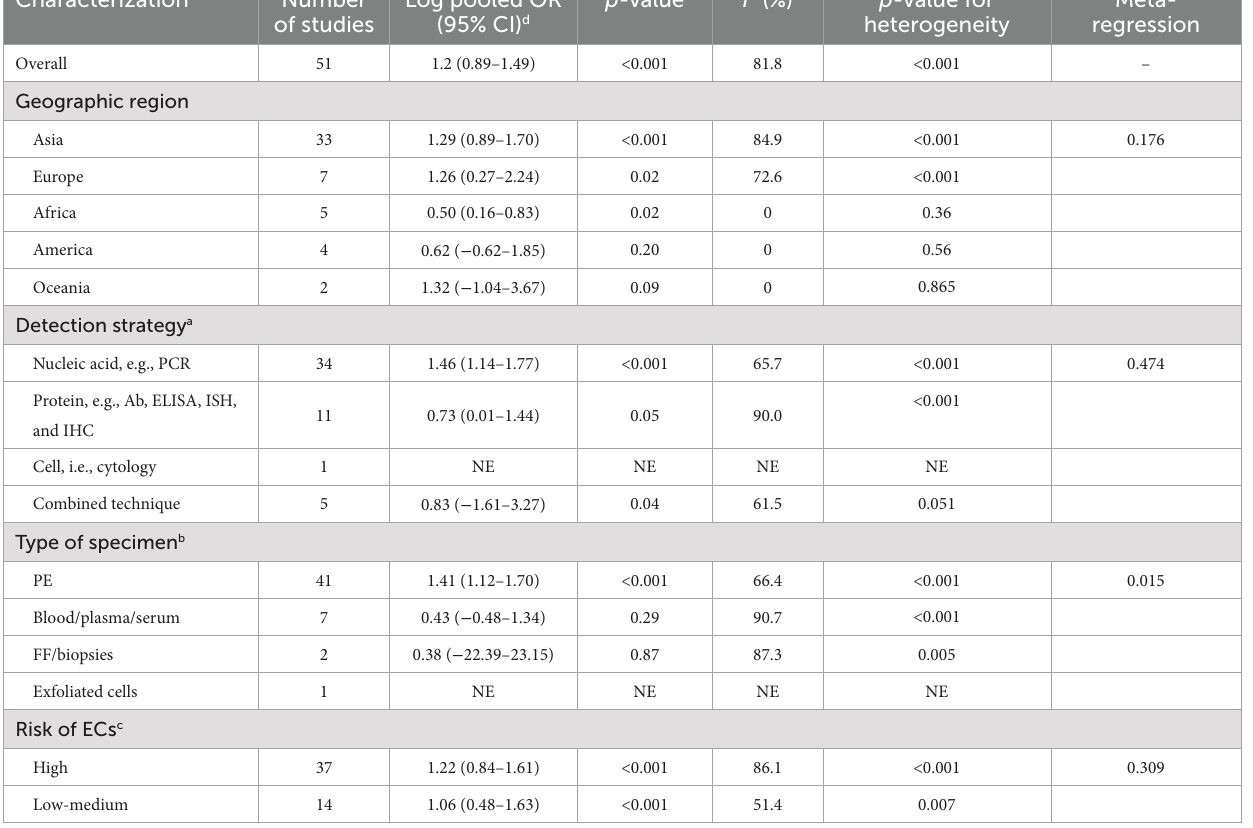
TABLE 5 Evaluation of the involvement of the HPV infection on EC risk in the subgroup context. Characterization Meta-